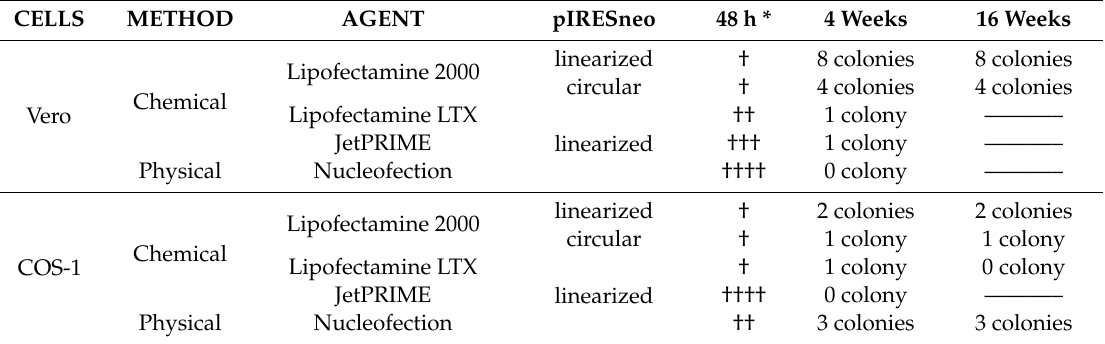
Table 1. Cells and transfection methodology, progression and outcome.